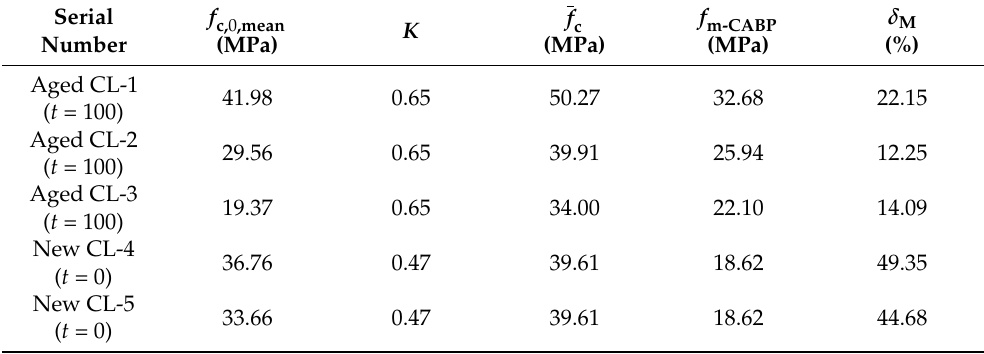
Table 7. Estimation of the compressive strength of the log samples, according to